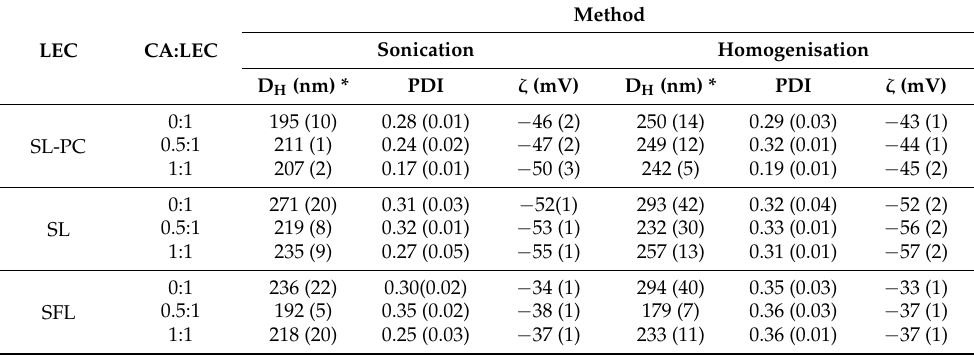
* Value corresponds to the main peak of distribution size (containing ≥ 94% of particles). Factors with a statistically significant effect with a 95% confidence level. DH: method ( p = 0.0003), lecithin ( p = 0.0048), CA:LEC ( p = 0.0001); PDI: method ( p = 0.0001), lecithin ( p = 0.0002), CA:LEC ( p = 0.0001); ζ : lecithin ( p = 0.0001), CA:LEC ( p =